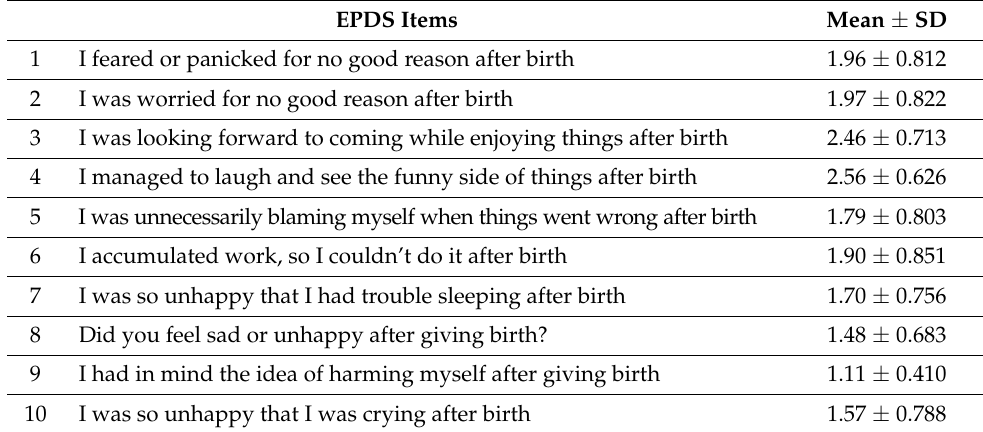
Table 5. Results for Edinburgh Postnatal Depression Scale (EPDS) items among the study participants.